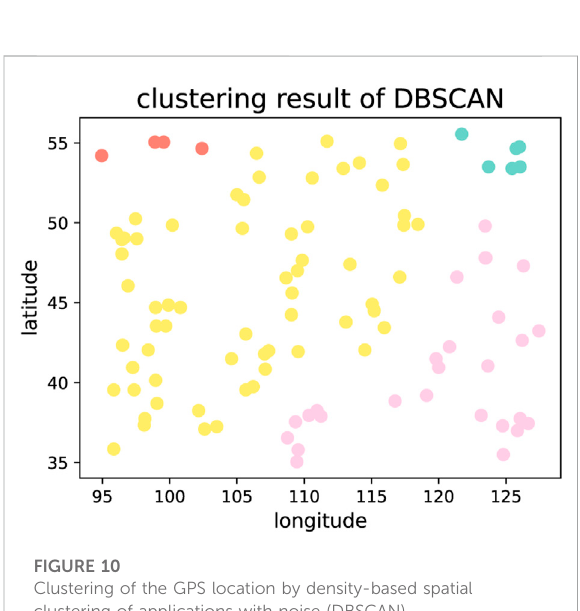
FIGURE 10 Clustering of the GPS location by density-based spatial clustering of applications with noise